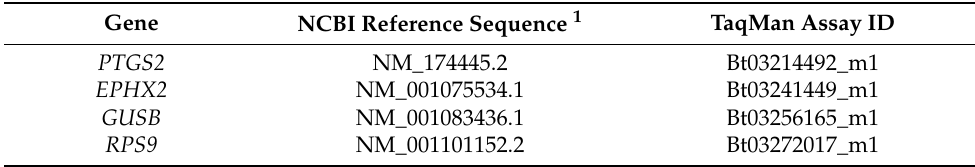
Table 1. Proprietary TaqMan primer reference